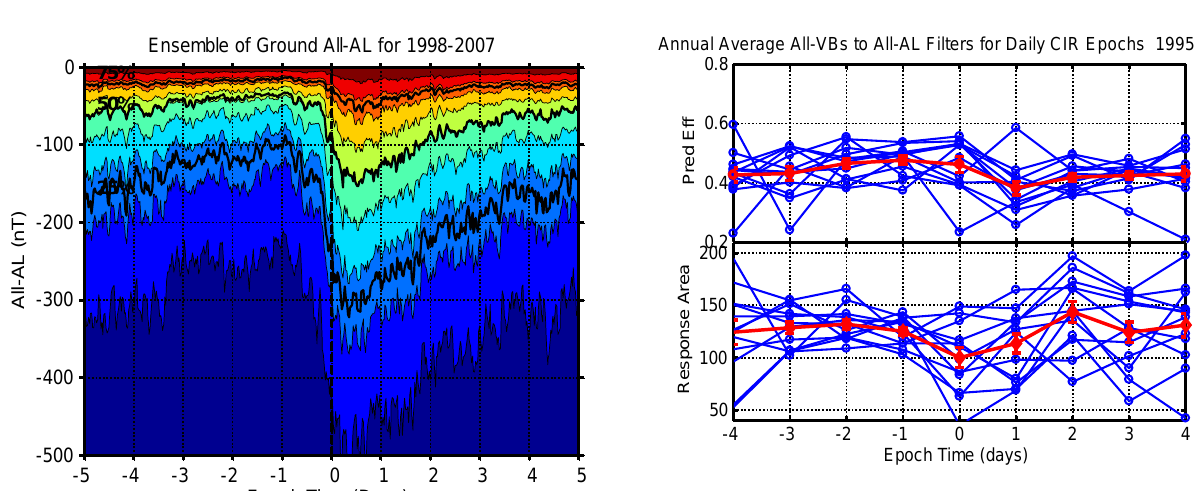
Figure 7. Results for13 annual ensemble average filters are plotted versus time relative to CIR stream interfaces in the years 1995-2007. Blue lines show the annual averages at each daily epoch while thick red lines are the means of all annual averages. Error bars are the standard error of the mean at each time. Note that the day-long intervals used in analysis were centered on the beginning of days.